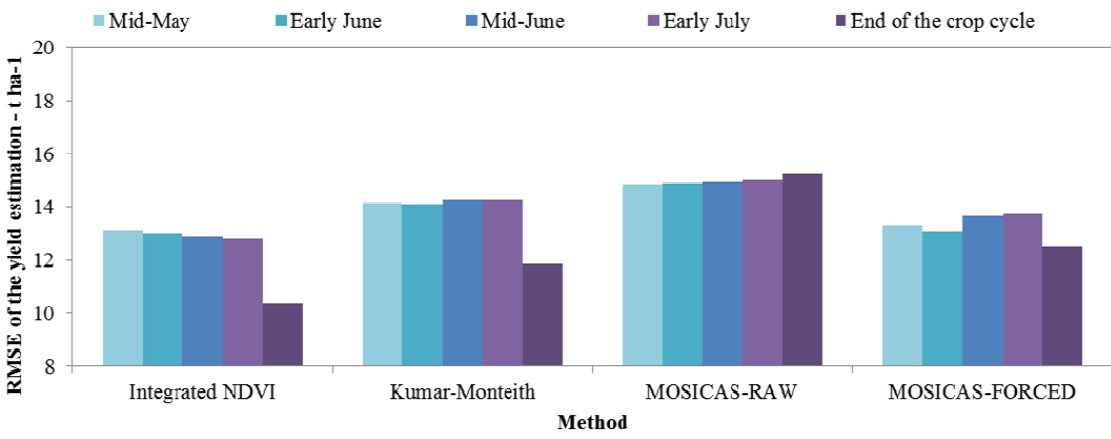
Figure 7. Influence of the yield forecast date on the accuracy of the forecasted